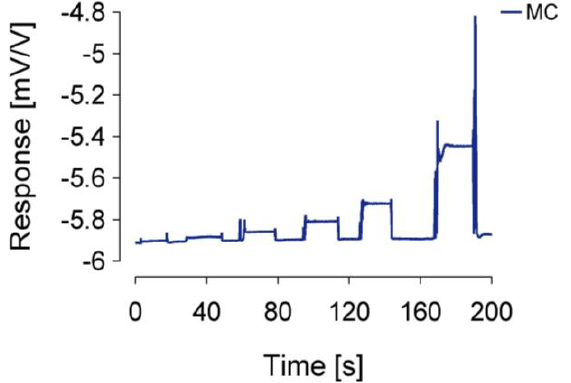
Figure 4. Timeline of MC output response at various weights hanged on the tonguelet.